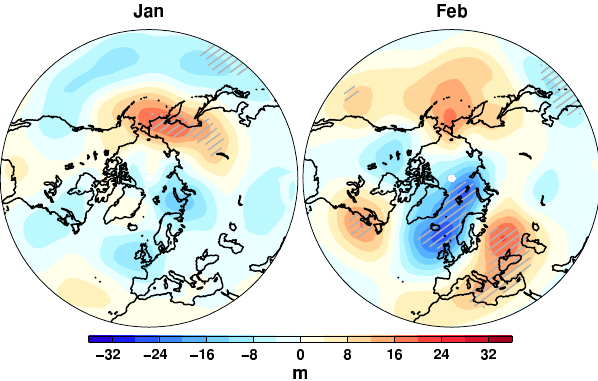
Figure 11. 500hPa geopotential height response to the 11-year solar cycle according to CMIP6-SSI in January and February as “ensem- ble mean” of CESM1(WACCM) and EMAC simulations; hatched areas denote statistical significance ( p < 5%) of shown